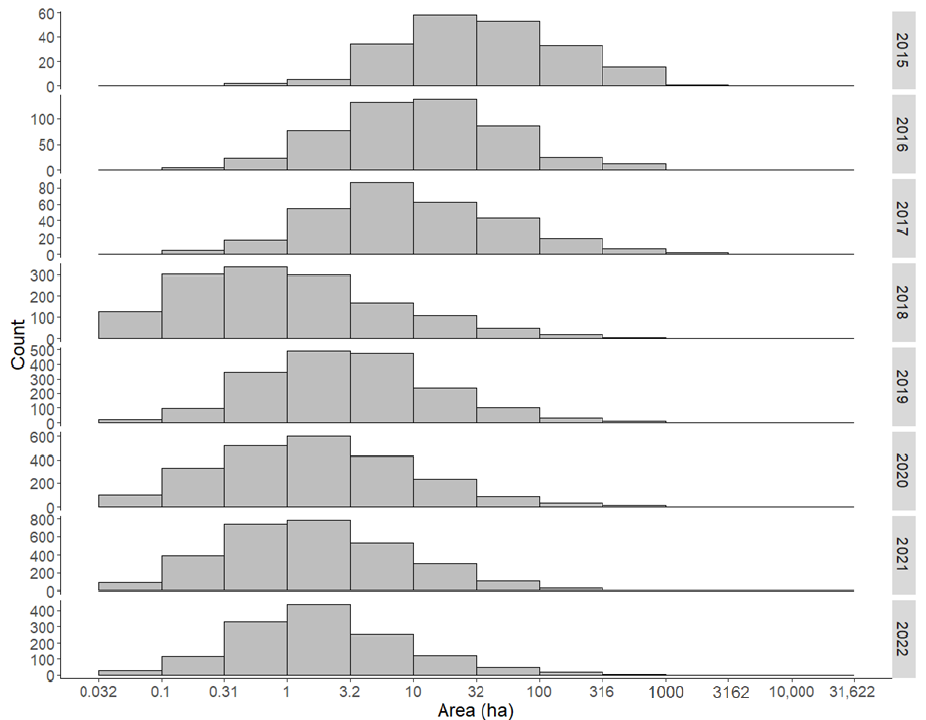
Figure 4. Distributions of burned areas between 2015 and 2022 (from INPA’s original database). Fire size is shown on a logarithmic scale. The shift of the histograms of 2018–2022 to the left, in comparison to those of 2015–2017, is due to the improved spatial resolution of Sentinel-2 in comparison with Landsat.